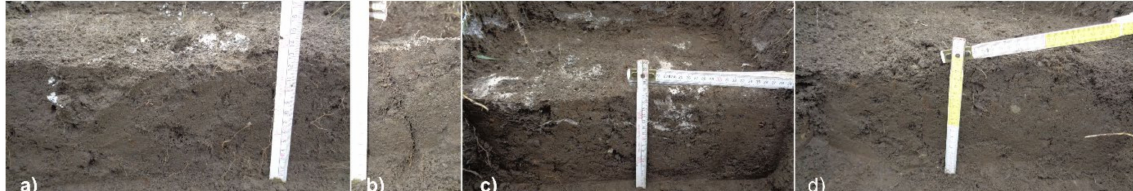
Figure 3. Soil profile analysis after infiltration test: ( a ) location VI (centre, left); ( b ) location IV (top, left) with small vertical crack structure and moderate infiltration; ( c ) location III (centre, left) with highest infiltration and strong soil texture; ( d ) location Va (top, right) with low infiltration and no desiccation